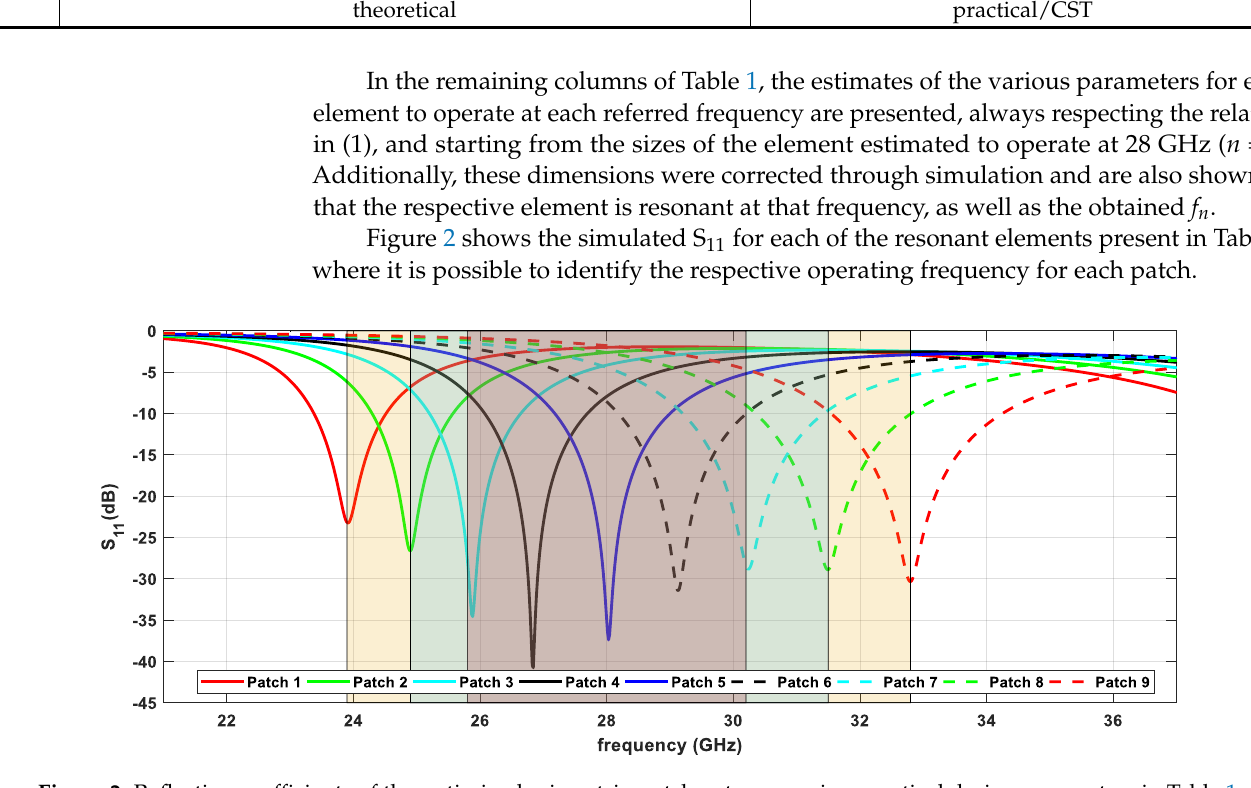
Table 1. Inset-fed microstrip antenna design parameters for a log-periodic structure with τ = 1.04.